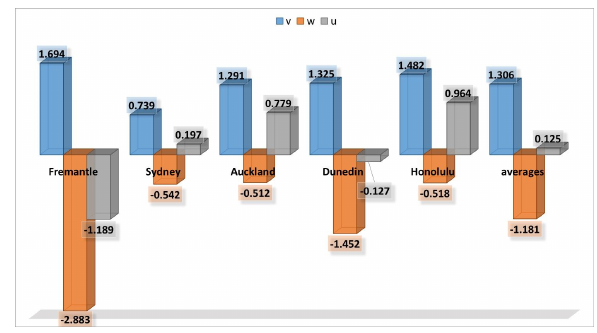
Figure 9: Summary of sea-level rise and subsidence results for the LTT stations of Oceania